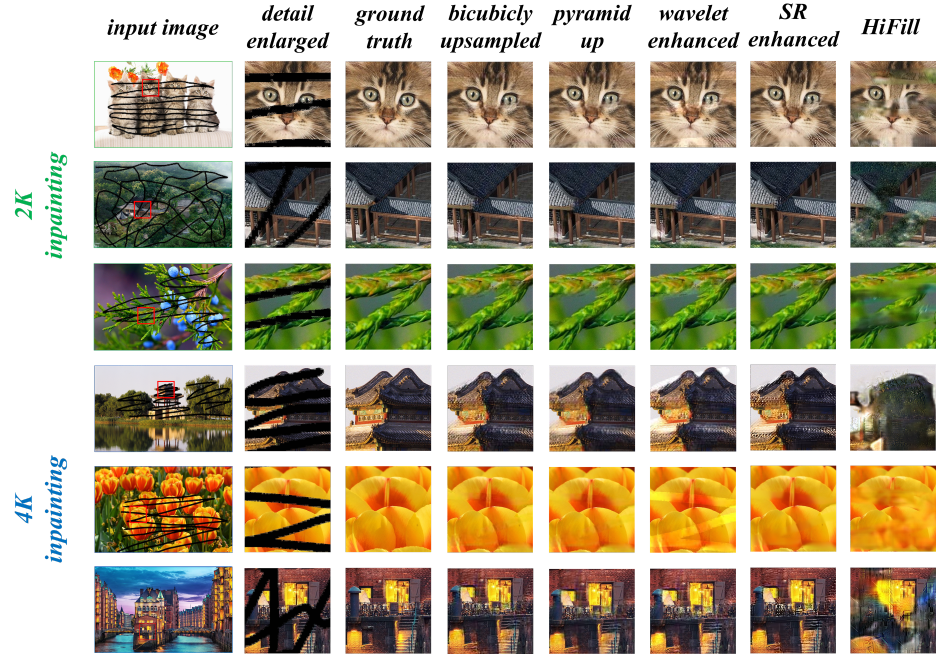
Figure 6. Zoomed-in comparison of 2K and 4K inpainted details: ( left to right ) input image, local details of ground-truth, local details of LR inpainting with bicubicly upsampling, local details of LR inpainting upsampled on Gaussian pyramid, local details of LR inpainting with wavelet enhancement, local details of LR inpainting with SR enhancement, local details of state-of-the-art technology.